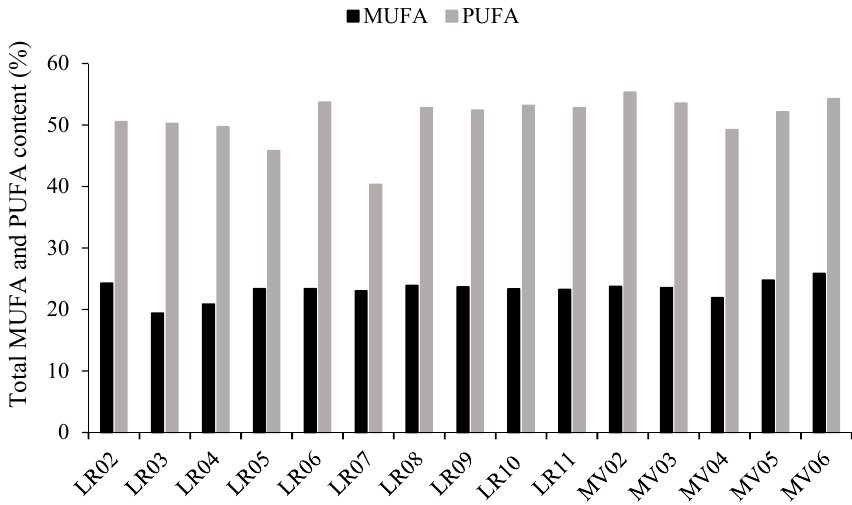
Figure 3. Total mono-unsaturated fatty acids (MUFA) and polyunsaturated fatty acid (PUFA) content of landraces and modern varieties.